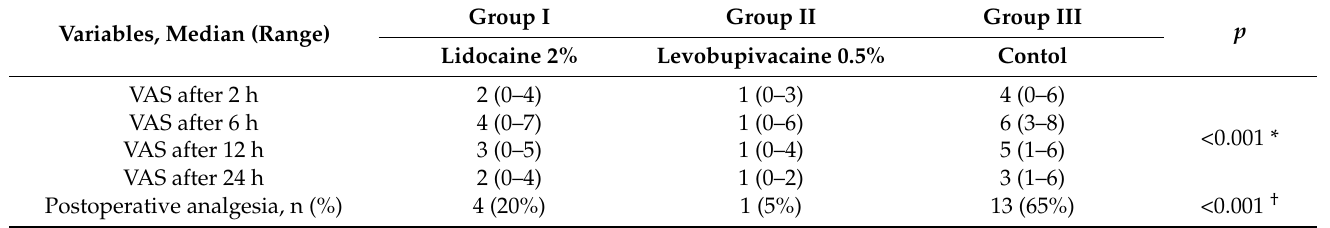
Table 2. Postoperative analgesia and pain level according to